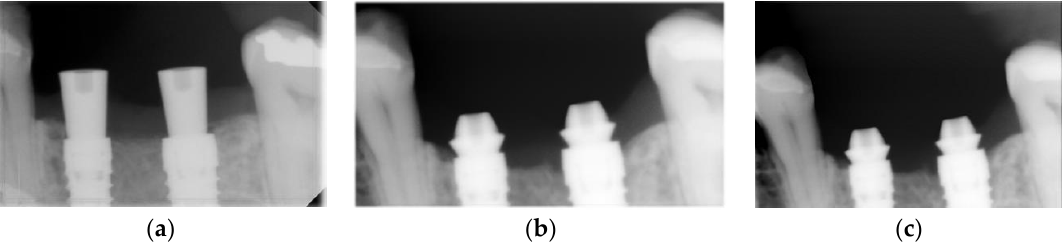
Figure 3. Case evolution control group. ( a ) Radiograph baseline; ( b ) Radiograph 6 months; ( c ) Radiograph 12 months.